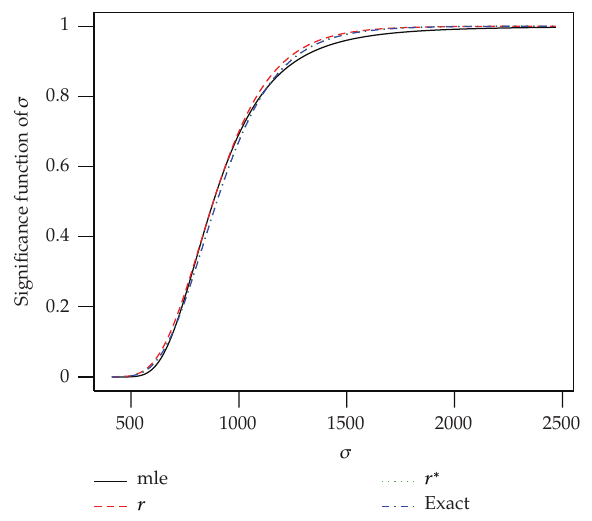
Figure 1: The significance function of σ .